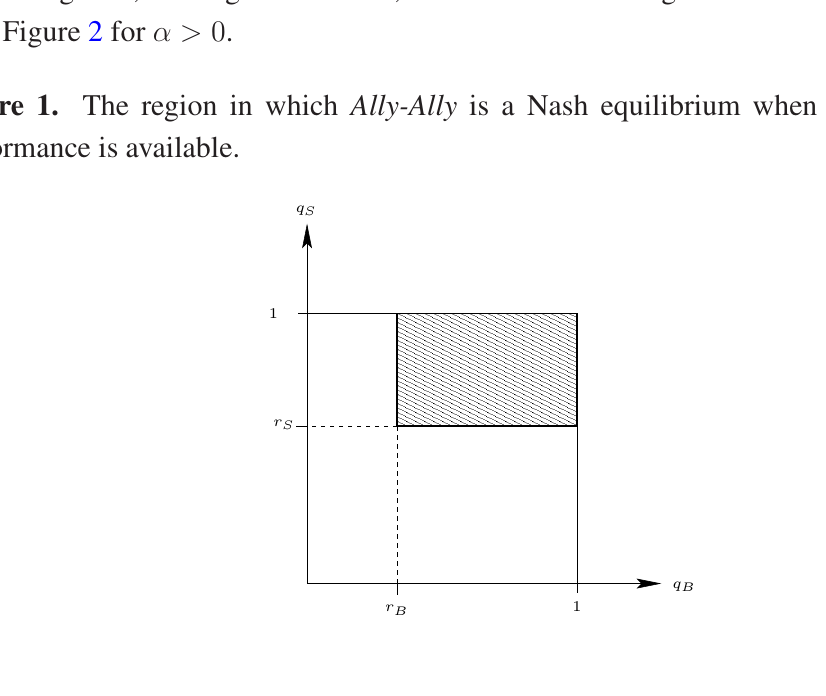
Figure 2. The region in which Ally-Ally is a Nash equilibrium when sharing improved market performance is